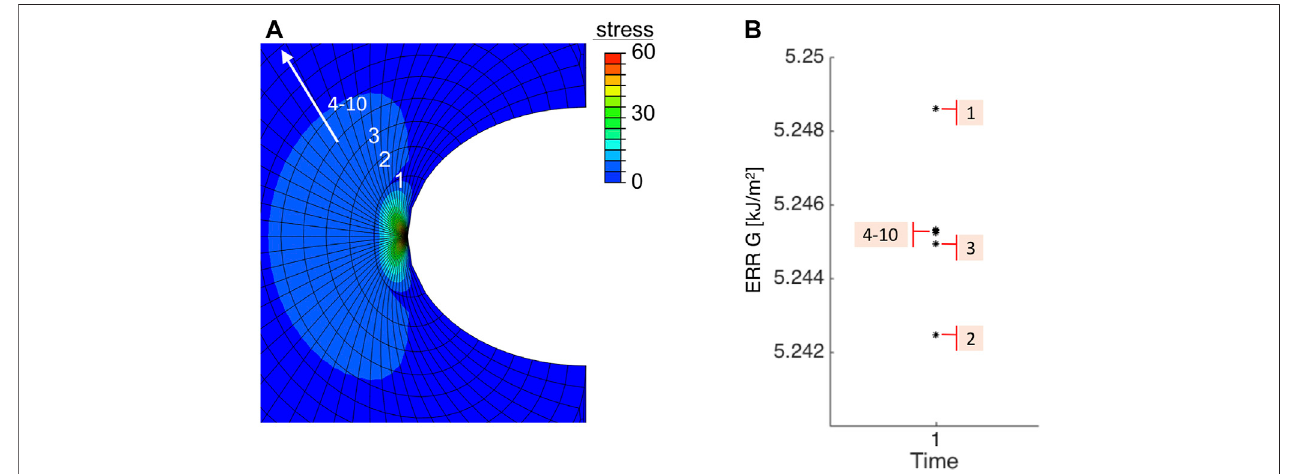
FIGURE5| Numericalresultof (A) themaximalprincipalin-planestressand (B) valuesofERRunder10contoursnearthecracktip.Notethatthe fi rstthreecontour integrals were neglected.